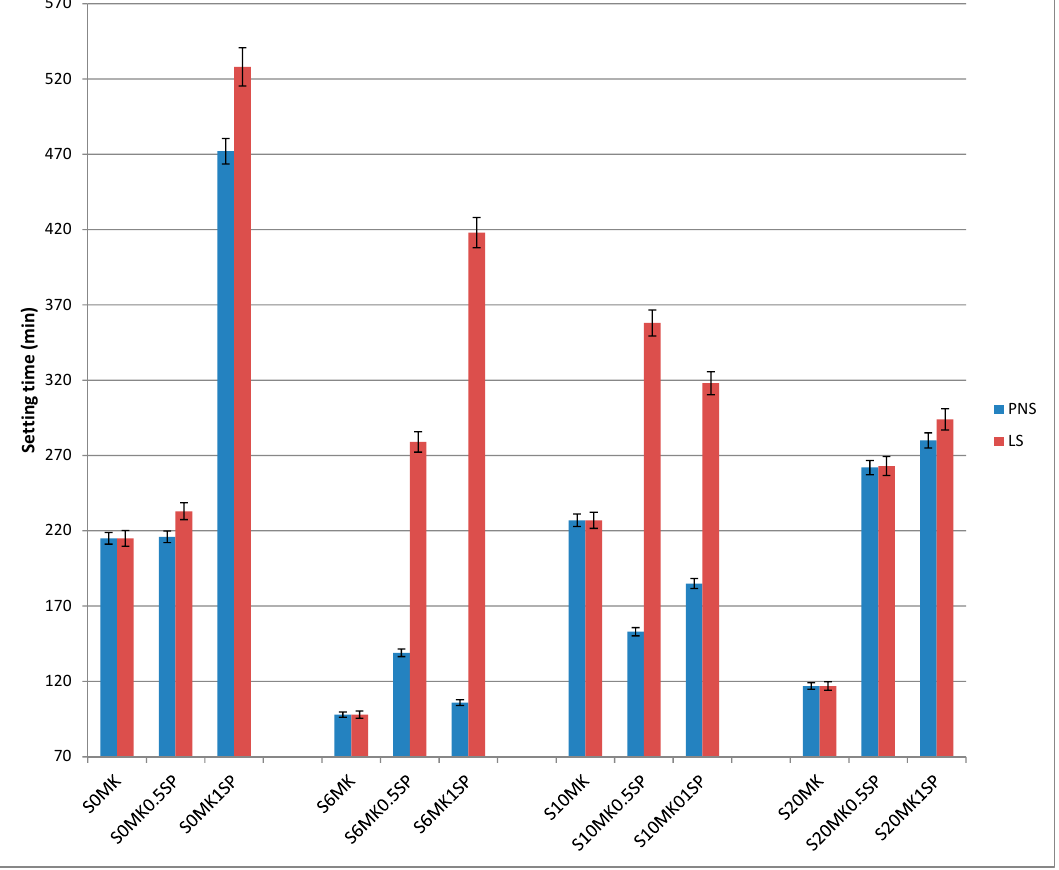
Figure 2. Setting time of the different grouts.